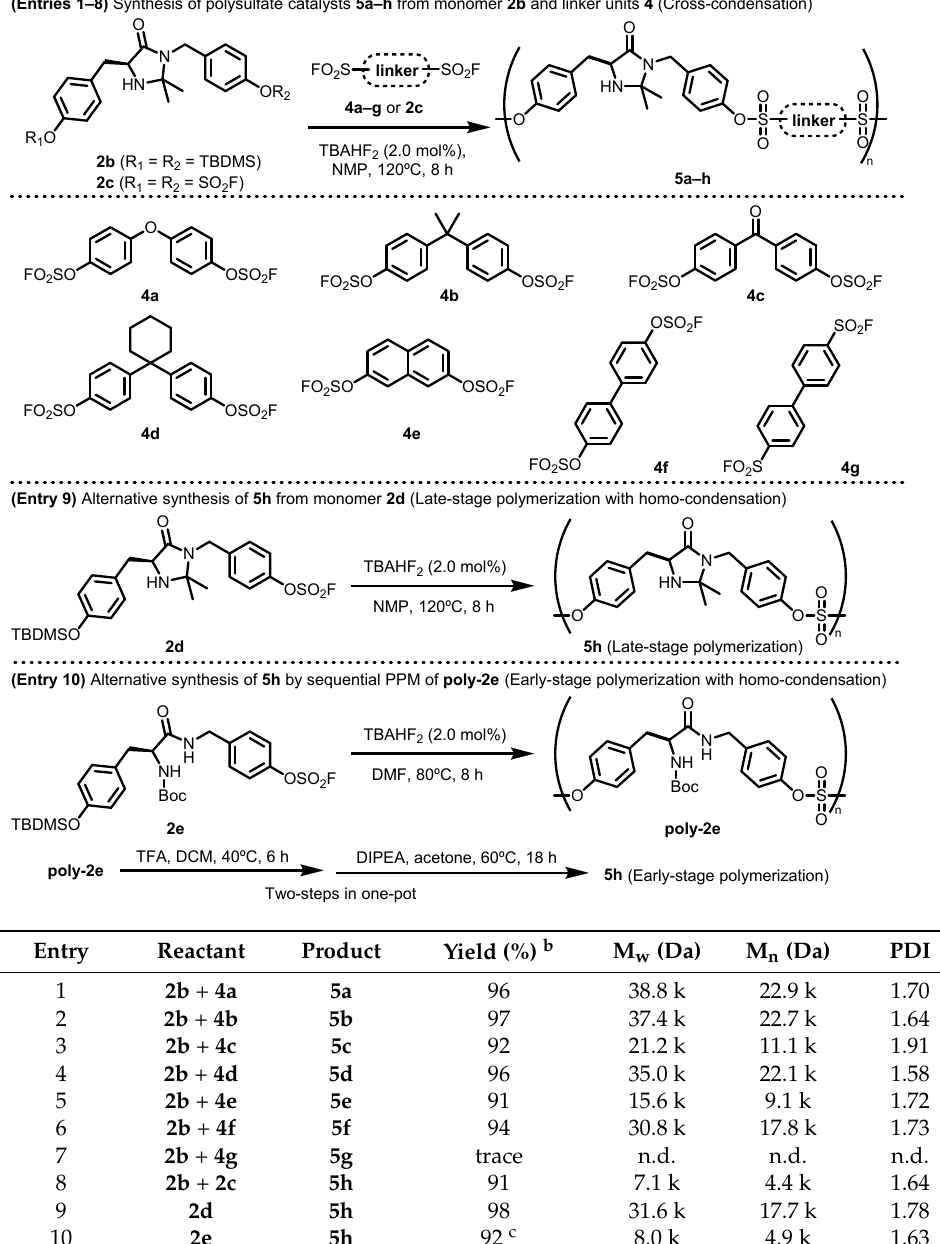
Table 1. Synthesis of Class I polymeric MacMillan catalysts a .